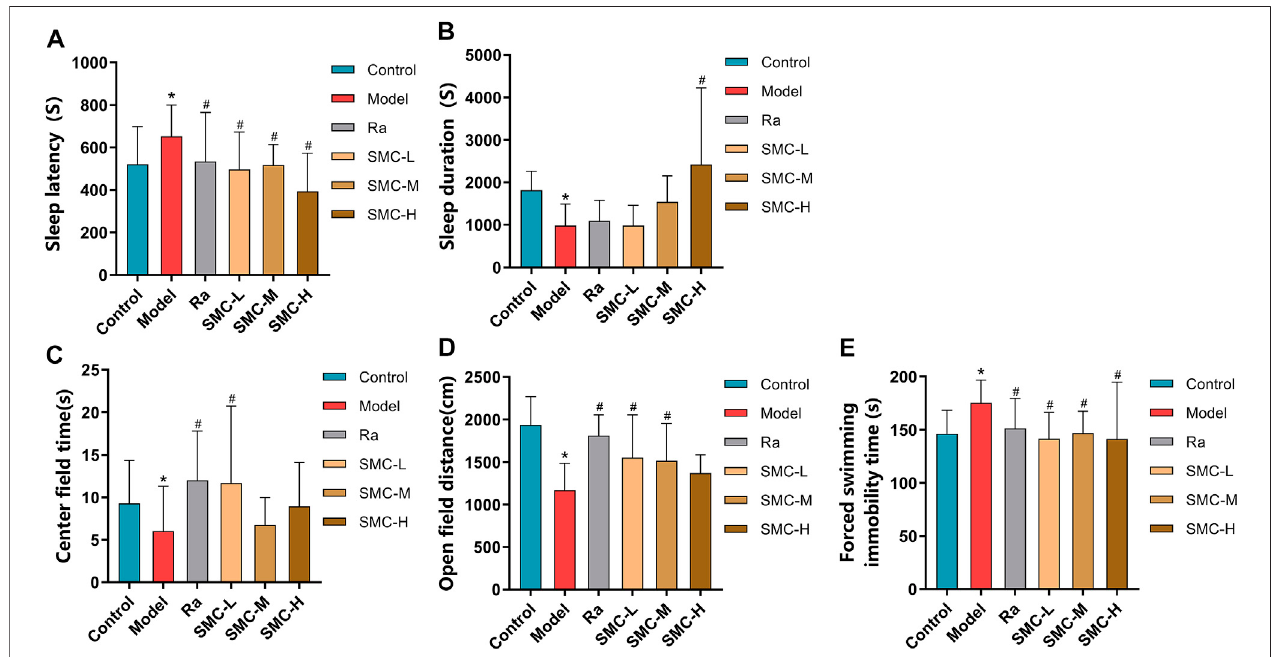
FIGURE5| Behavioralexperimental indexesofsleep-deprivedmiceafterbeingtreatedwithramelteonandSMC( n =11 – 14). (A) Sleeplatency. (B) Sleepduration. (C) Center fi eld time of OFT. (D) Open- fi eld distance of OFT. (E) Immobility time of FST. * p < 0.05 vs . control group; # p < 0.05 vs . model group. All the data were represented as the mean ±